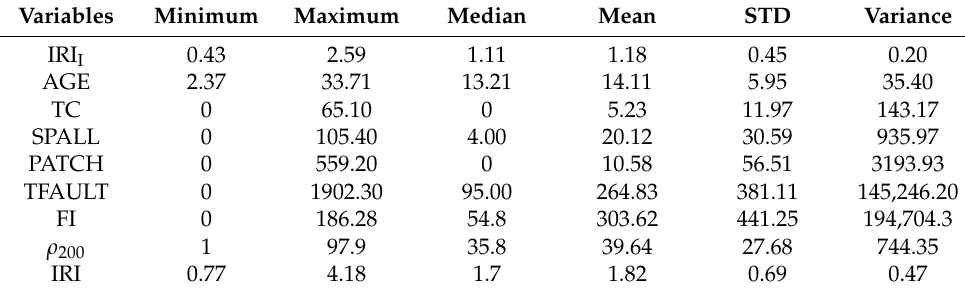
Table 1. Variable data analysis.